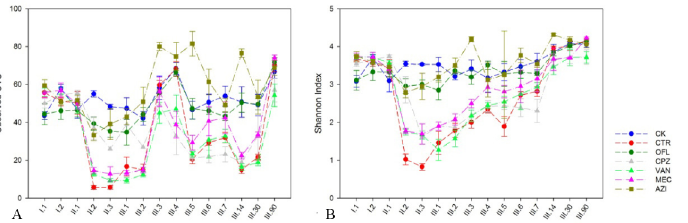
Fig 1. α -diversity indices for different antibiotic groups from the fecal microbiota. A. Chao1 index; B. Shannon